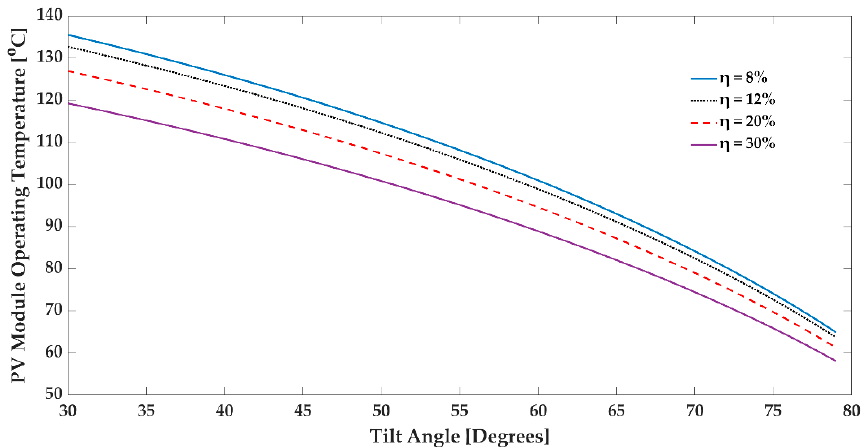
Figure 8. PV module operating temperature vs. tilt angle with specified solar flux at γ = 90° on an inclined PV module. The tilt angle is 30° ≤ θ ≤ 80° and the solar flux is Gt = 1000 W/m 2.